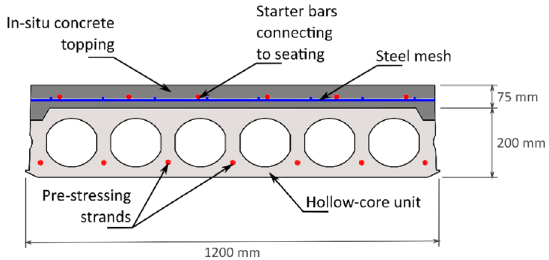
Fig. 1 Typical hollow-core floor